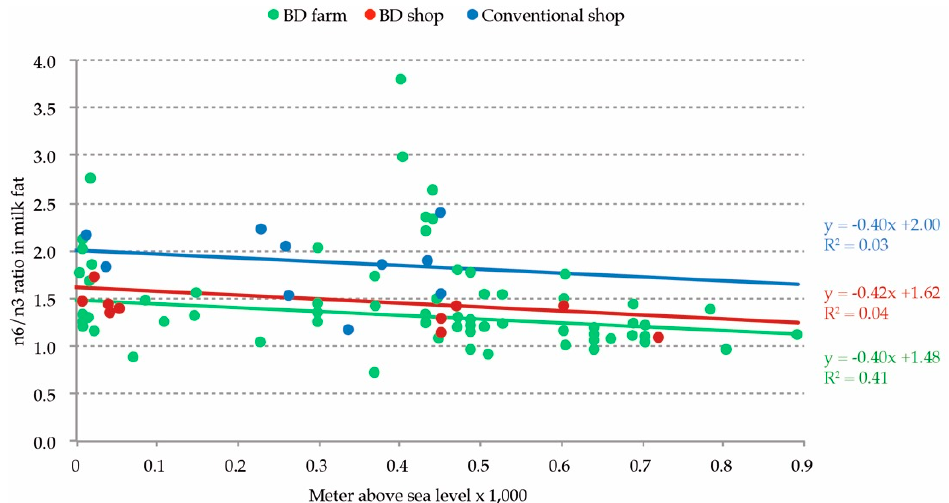
Figure 2. The relationship between the elevation of the creamery and the ratio of n6/n3 in the milk fat of the biodynamic (BD) summer shop milk (N = 10), conventional summer shop milk (N = 10), and biodynamic farm milk samples in the summer (N = 89).